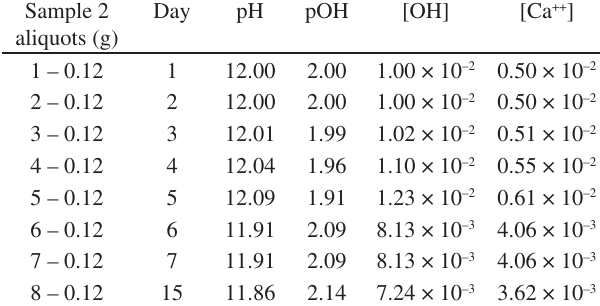
Table 2. pH of the aliquots of sample 2. Sample 2